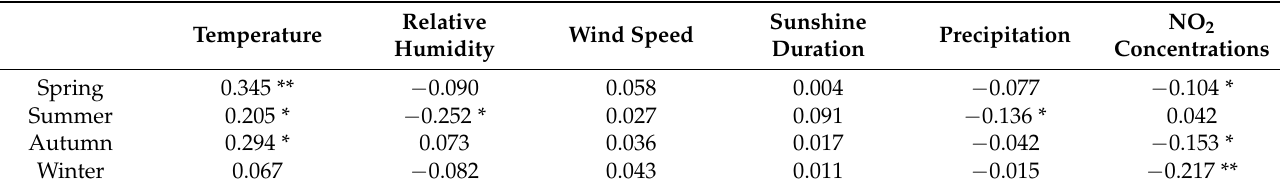
Table 1. Seasonal geographical detection of the driving